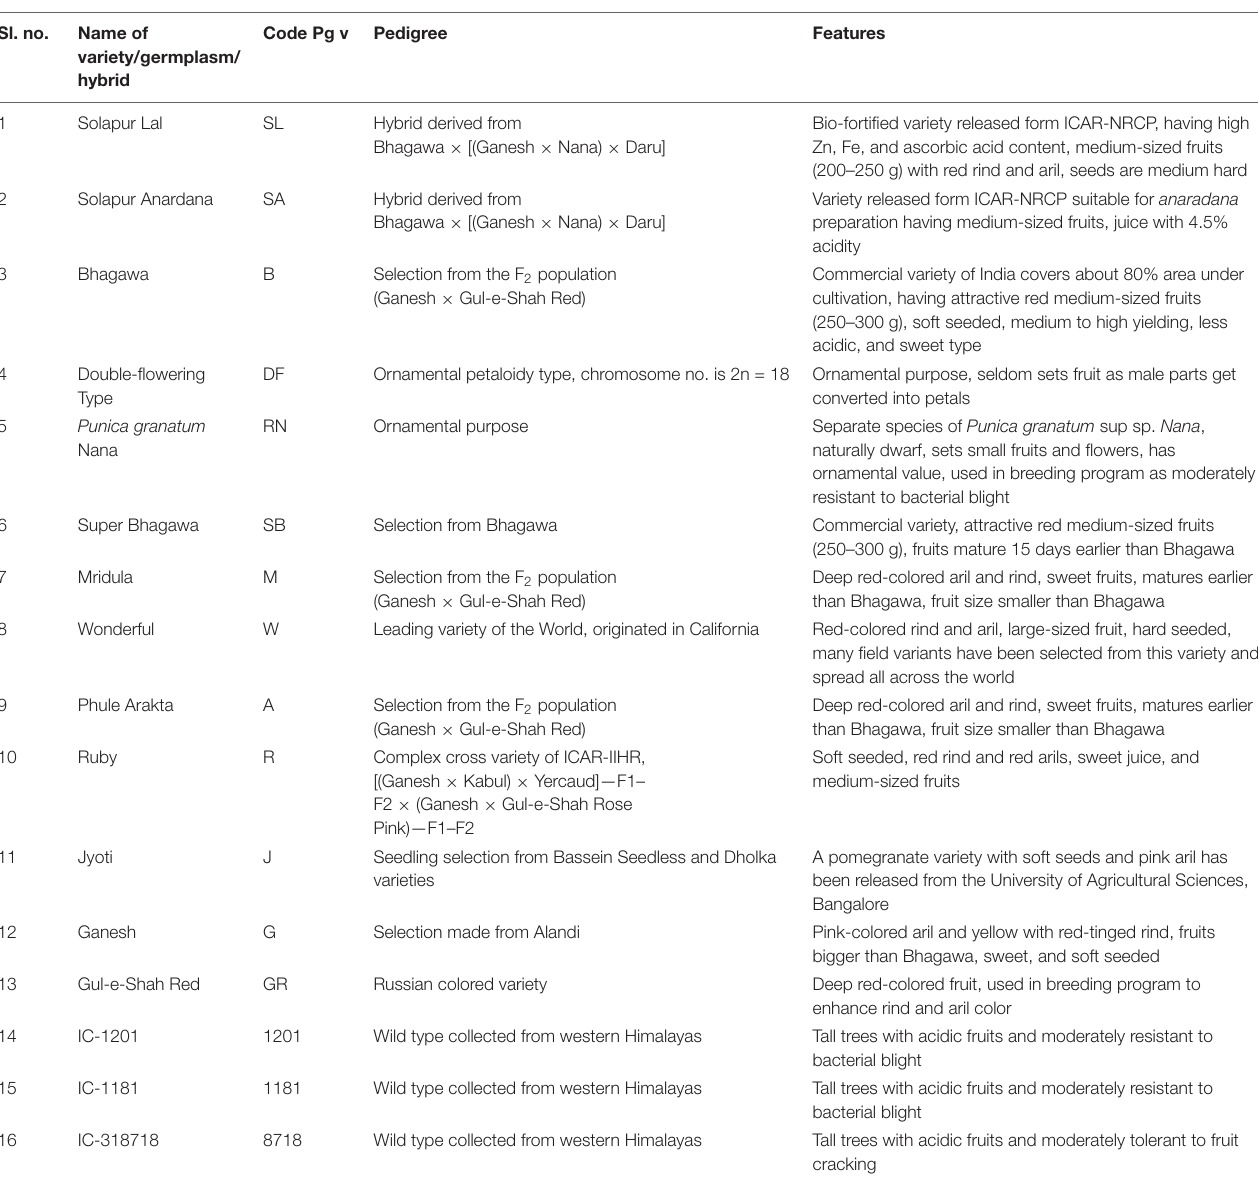
TABLE 1 | Pomegranate genotypes with their special features. Sl.